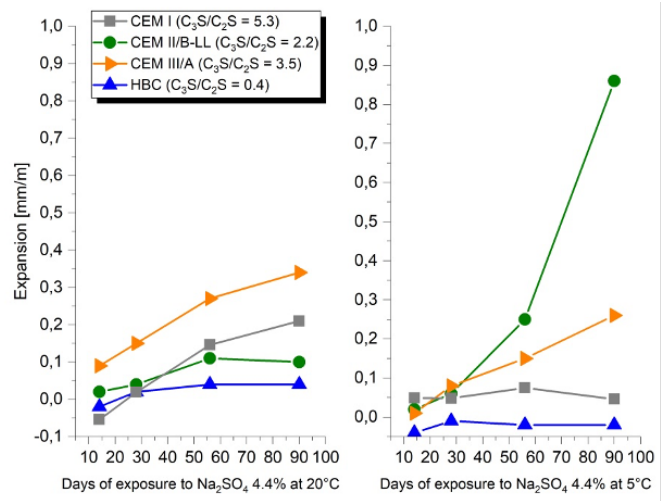
Figure 5. Expansion due to sulfate attack at 20 ◦ C and 5 ◦